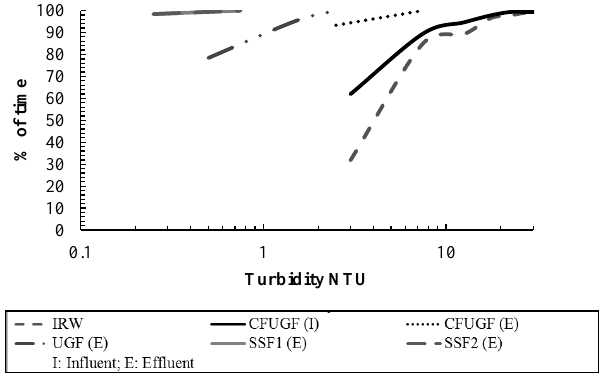
Figure 7. Frequency of turbidity levels (operation with coagulant). 76 %. The removal e ffi ciencies in CF-UGF with velocity gra- dients between 28.5–3.1 s − 1 (for 3 and 6 l s − 1 ) was